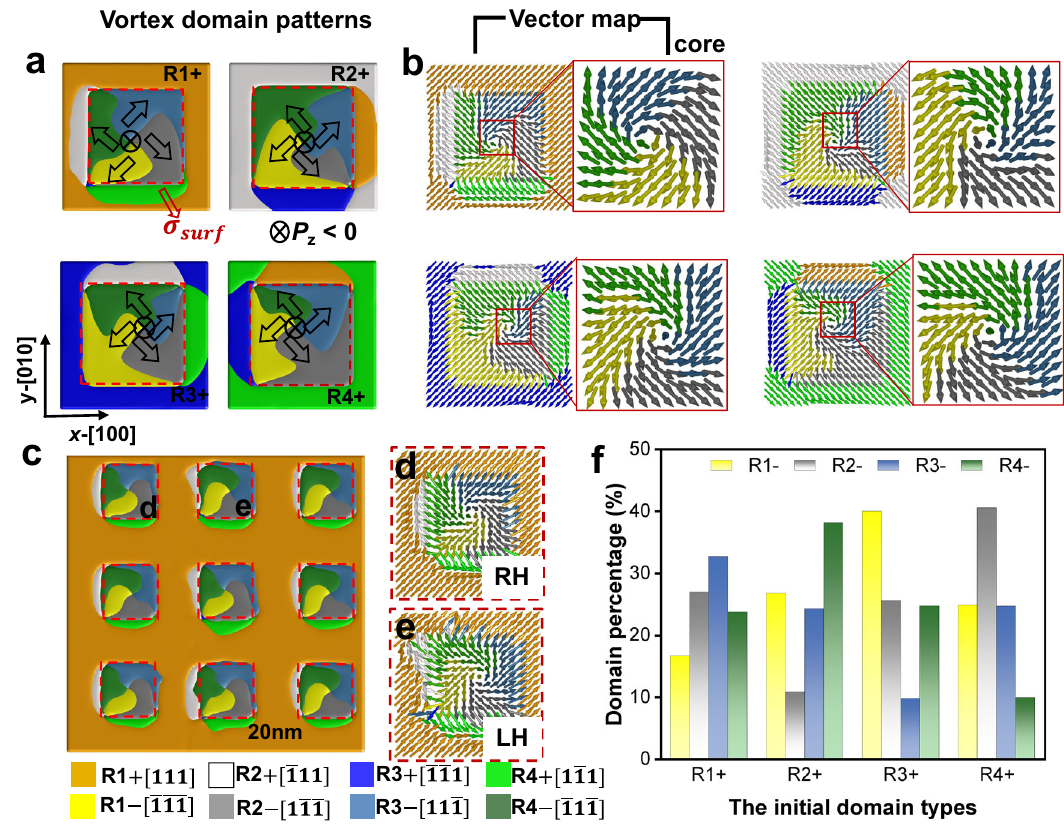
Fig. 2 Chiral polar vortices induced by applying a local square-shaped positive surface charge. a The vortex domain patterns in four initial upward single domains (R1 + , R2 + , R3 + , and R4 + , respectively). b The projection of the polarization vector. c Nine vortices are induced by applying nine charge regions on large-scale BFO thin fi lm with an initial R1 + domain. The polarization vector distribution of RH vortex in d and LH vortex in e . f The fi nal domain percentages in a vortex indued in four initial domains. Yellow, gray, steel-blue, and steel-green regions represent domains with polarization along with R1 − ( ½ 111 (cid:2)Þ , R2 − ([ 111 ]), R3 − ([ 111 ]), and R4 − ([ 111 ]) directions,